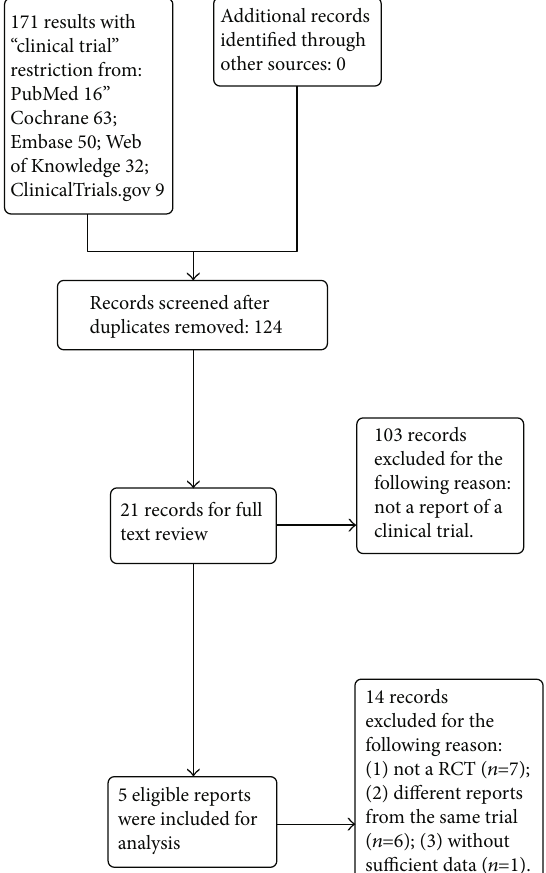
Figure 1: Flow chart for selection of relevant